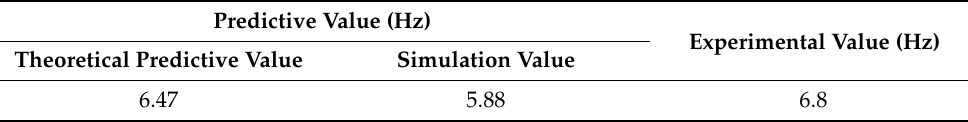
Table 6. Comparison between the measured and predicted values of the first-order natural frequency of wood